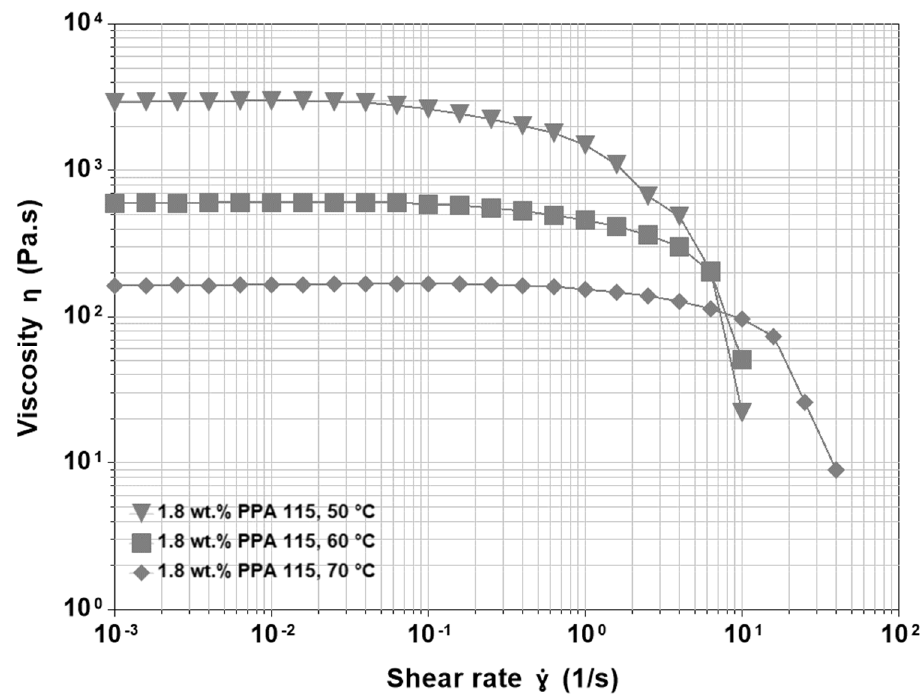
Figure 2. Viscosity functions at different temperatures for 200/300 Pen grade modified by 1.8 wt.% PPA 115.